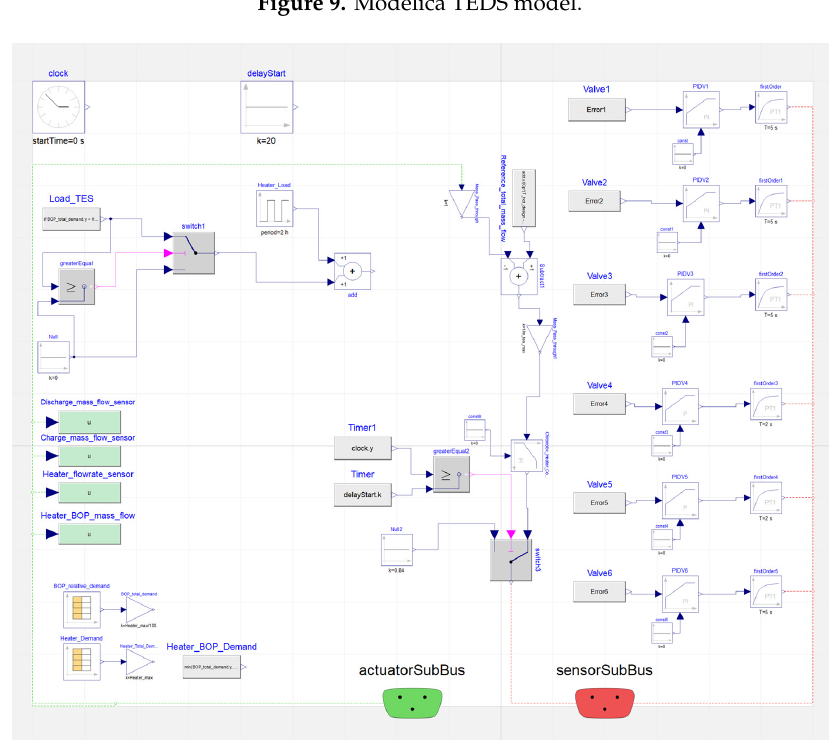
Figure 10. Pictorial layer of the control algorithm.